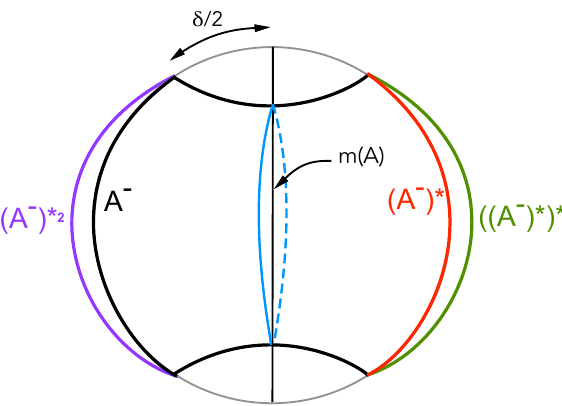
Figure 15 . The entire boundary region is AA ? , and the vertical line is the RT surface for A denoted m ( A ) . ρ is the density matrix on A − ( A − ) ? , where A − ⊂ A , ( A − ) ? ⊂ A ? , obtained A − ( A − ) ? using a corridor region of length δ/ 2 . Its canonical purification, A − ( A − ) ? ( A − ( A − ) ? ) ? 2 Hilbert space. The reflected minimal surface for A − ( A − ) ? 2 (in blue) lives on the twice doubled wedge, such that S R ( A − : ( A − ) ? ) / 2 approaches S ( δ ) acting as a regulator for m ( A )